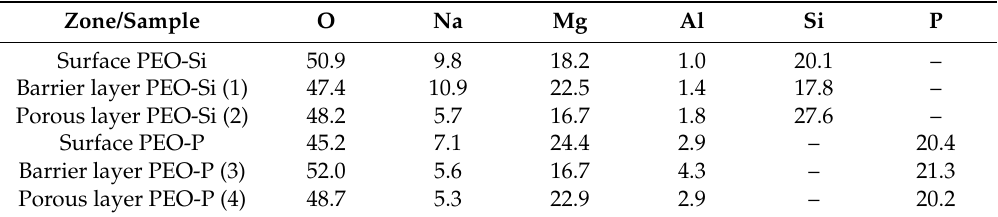
Table 2. EDS microanalysis (wt %) obtained on different zones of the surface and cross section of the samples PEO-Si and PEO-P.